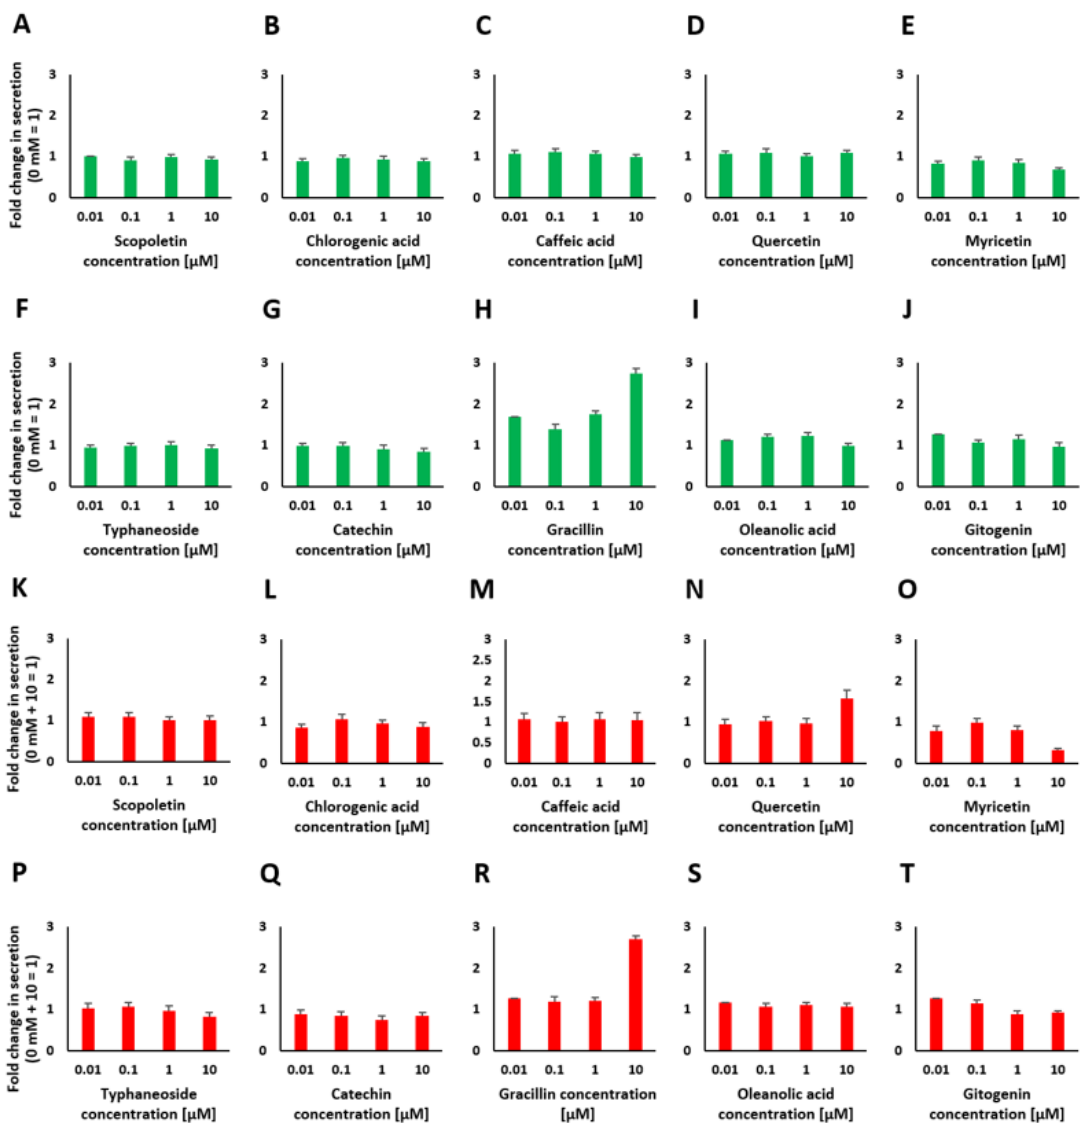
Figure 6. Insulin secretion in response to stimulation with various concentrations of identified bioactives ( A – J ) and insulin secretion in response to stimulation with 10 mM glucose after preincubation with various concentrations of bioactives to test for insulin secretion inhibiting properties ( K – T ).